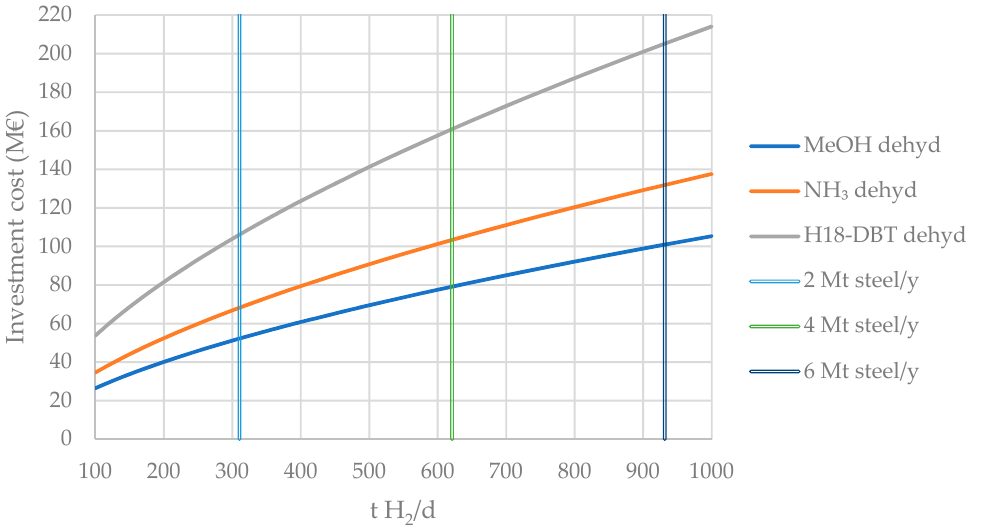
Figure 7. Dehydrogenation plant investment costs for different liquid H 2 carriers. H 2 demand of dehydrogenation plant to fully supply H-DR process at different production scales also indicated (assumed 0.9 capacity factor, 51 kg H 2 /t steel).